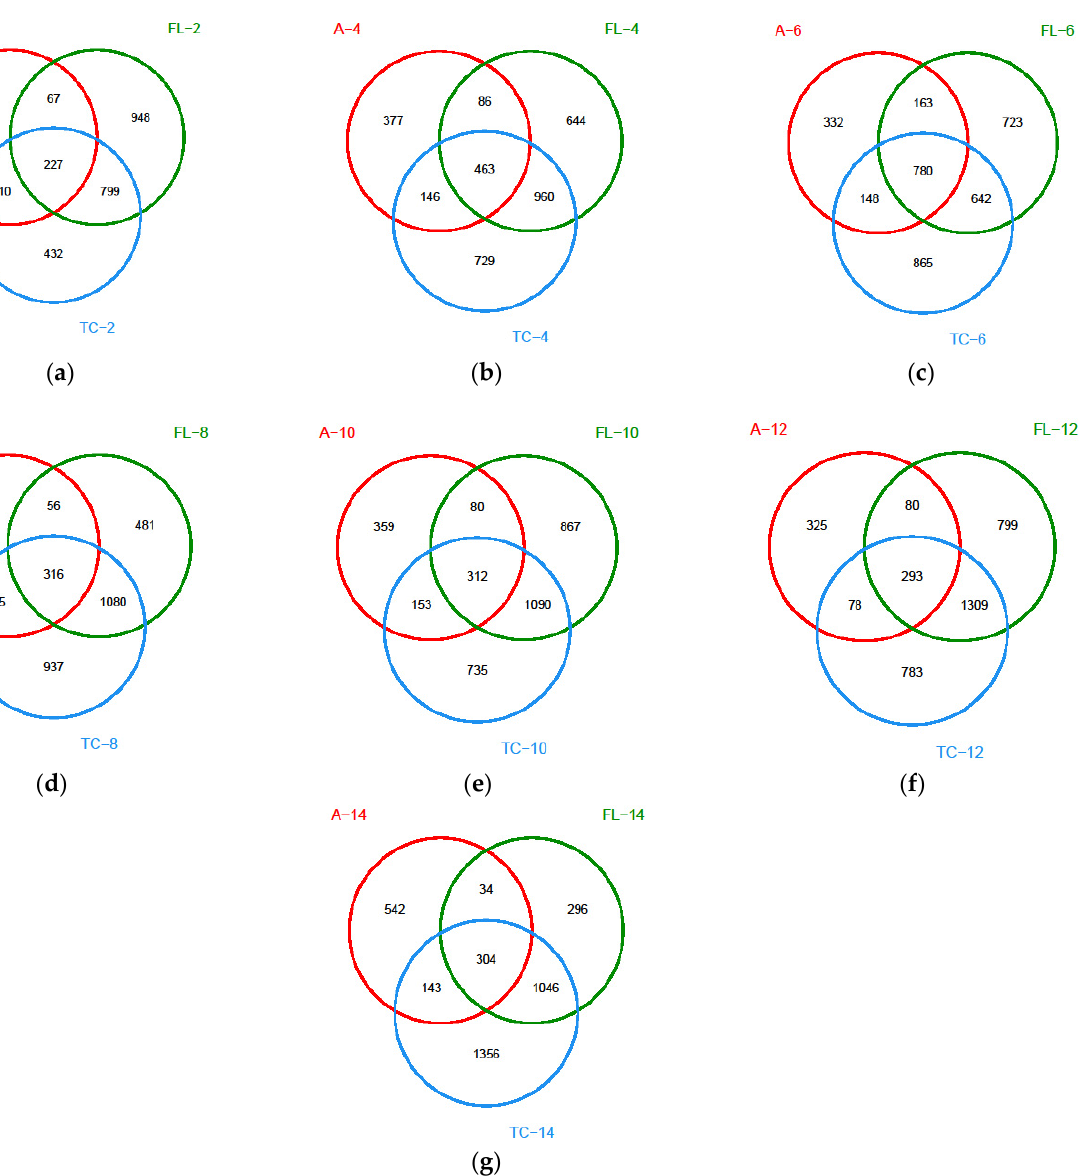
Figure 8. Venn diagrams of microorganisms at three locations (“A” in the figure represented air microorganisms, “FL” represented forelegs microorganisms, and “TC” represented thoracic microorganisms) during the same cooling time (( a – g ) were cooling for 2 h, 4 h, 6 h, 8 h, 10 h, 12 h, and 14 h, respectively).